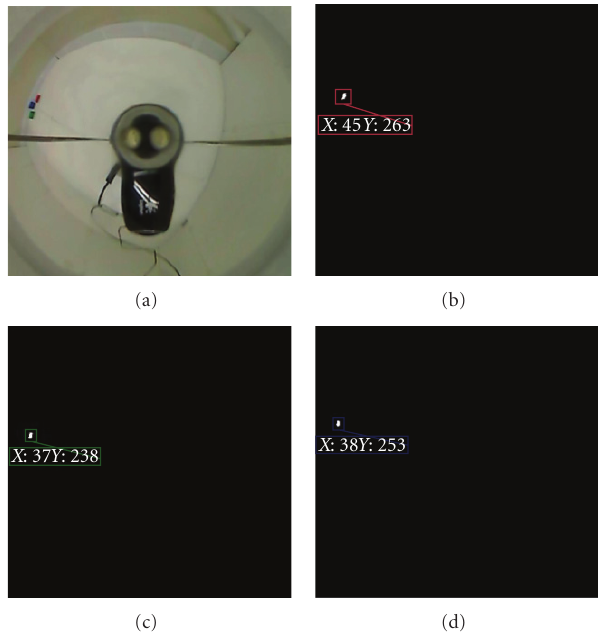
Figure 11: The process of detecting the beacons: (a) an image frame received from the camera, (b) red beacon detection, (c) green beacon detection, (d) blue beacon detection.